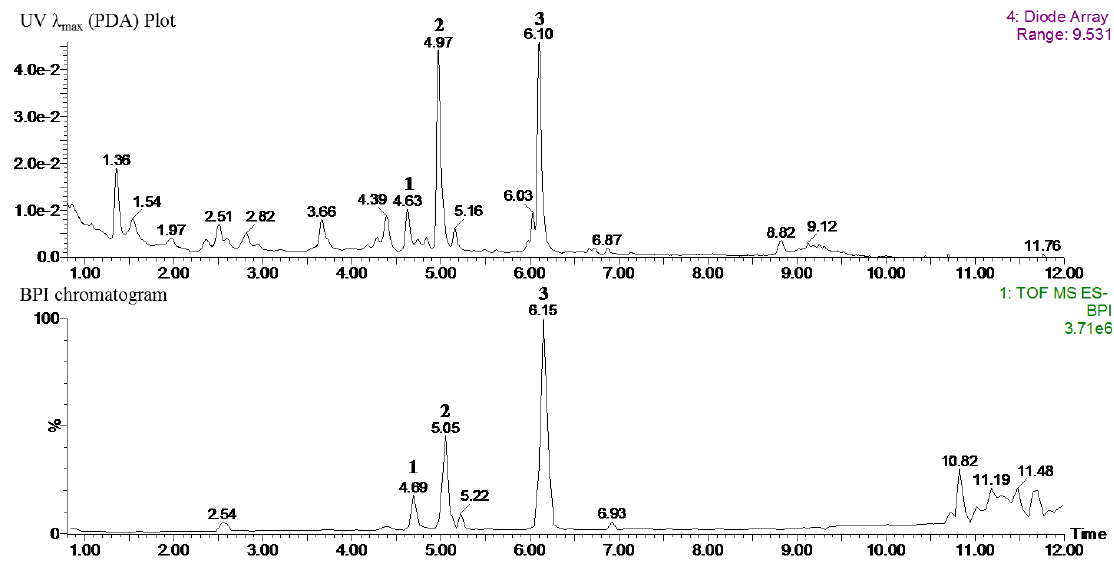
Figure 8. UPLC-PDA-QT of MS chromatograms of NZS extract: 6-methoxykaempferol-3- O -β- D -glucosyl(1′′′ → 2′′)-β- D -glucopyranoside ( 1 ), 6-methoxykaempferol-3- O -β- D -glucosyl(1′′′ → 2′′)-β- D -glucopyranosyl-(6′′′′-caffeoyl)-7- O -β- D -glucopyranoside ( 2 ), and 6,4′-dimethoxykaempferol-3- O -β- D -glucosyl(1′′′ → 2′′)-β- D -glucopyranosyl-(6′′′′-caffeoyl)-7- O -β- D -glucopyranoside ( 3 ).